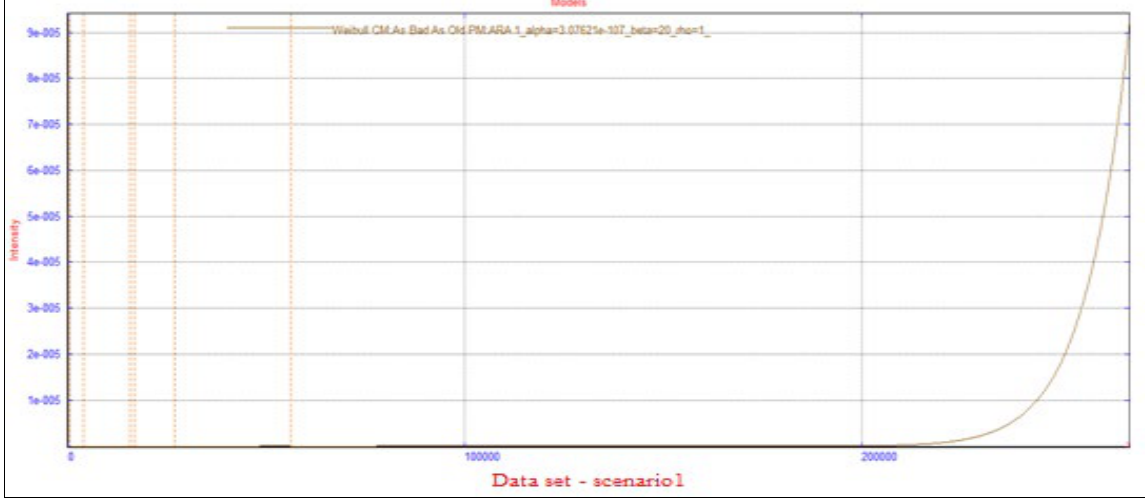
Figure 2. Failure intensity of scenario 1 for model CM ABAO – PM ARA